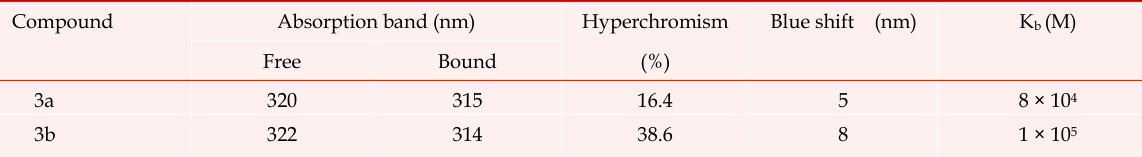
Percentage hyperchromism and hypsochromic shift of compounds (3a and 3b) Compound